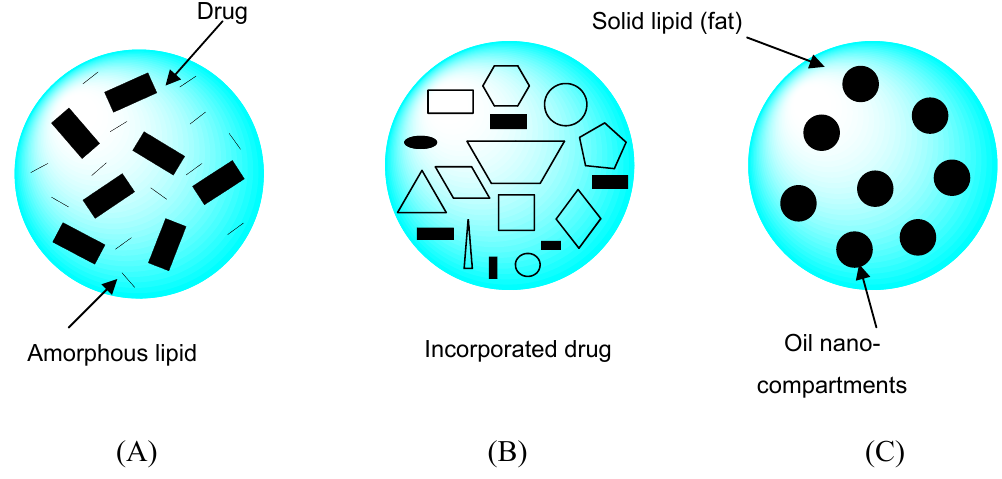
Figure 4. Three different types of nanostructured lipid carriers (NLCs) compared to the more or less highly ordered matrix of solid lipid nanoparticles (SLNs). The three types of NLC can be summarized as: (A) the amorphous type, (B) imperfect type, and (C) multiple type. This figure is modified from reference [